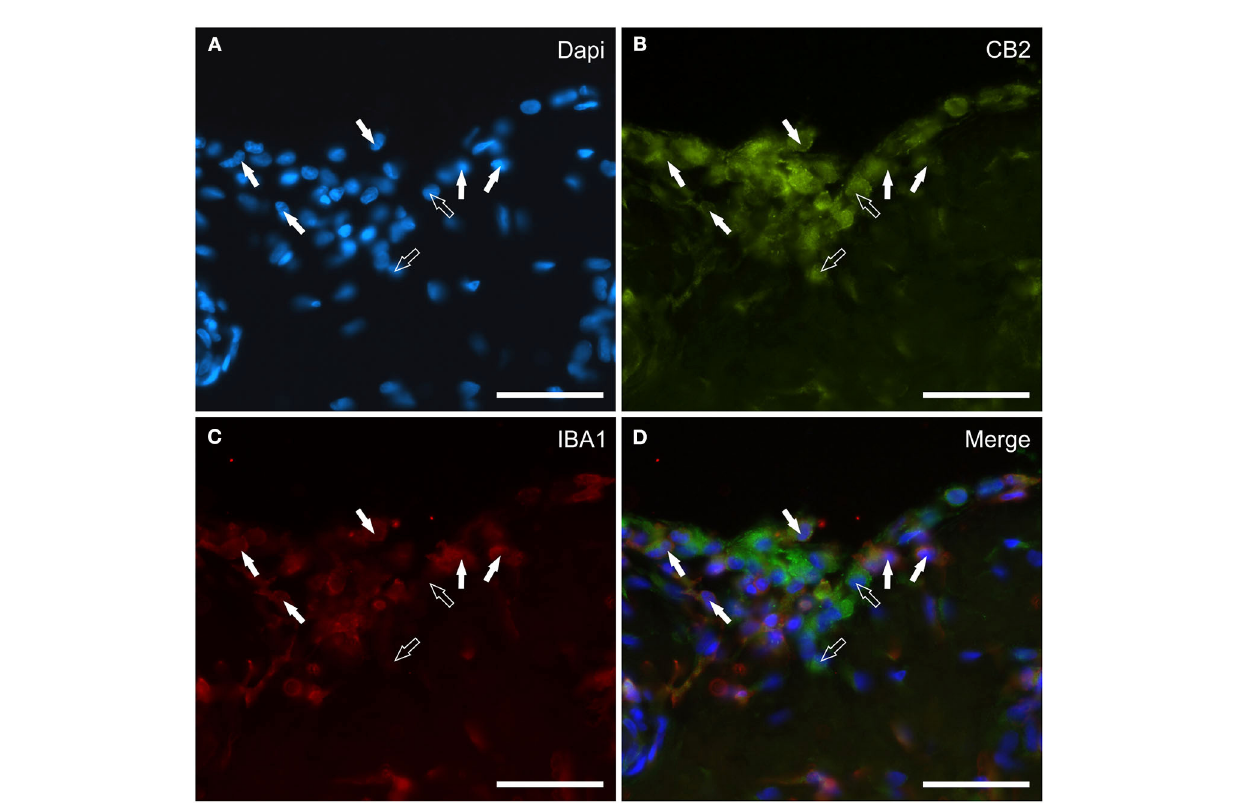
FIGURE4 Photomicrographs of the cryosections of the synovial membrane of a horse metacarpophalangeal joint showing cannabinoid receptor type 2 (CB2) (B) and IBA1 (C) immunoreactivity. The white arrows indicate the DAPI (Blue) labeled nuclei (A) of some round macrophage-like synoviocytes lining the joint cavity which co-expressed IBA1 (Red) and bright CB2 (Green) receptor immunoreactivity. The open arrows indicate two cells expressing CB2 receptor immunoreactivity (likely fibroblast-like synoviocytes) which were IBA1 negative. (D) Merged image (Orange). Scale bar = 50 µ